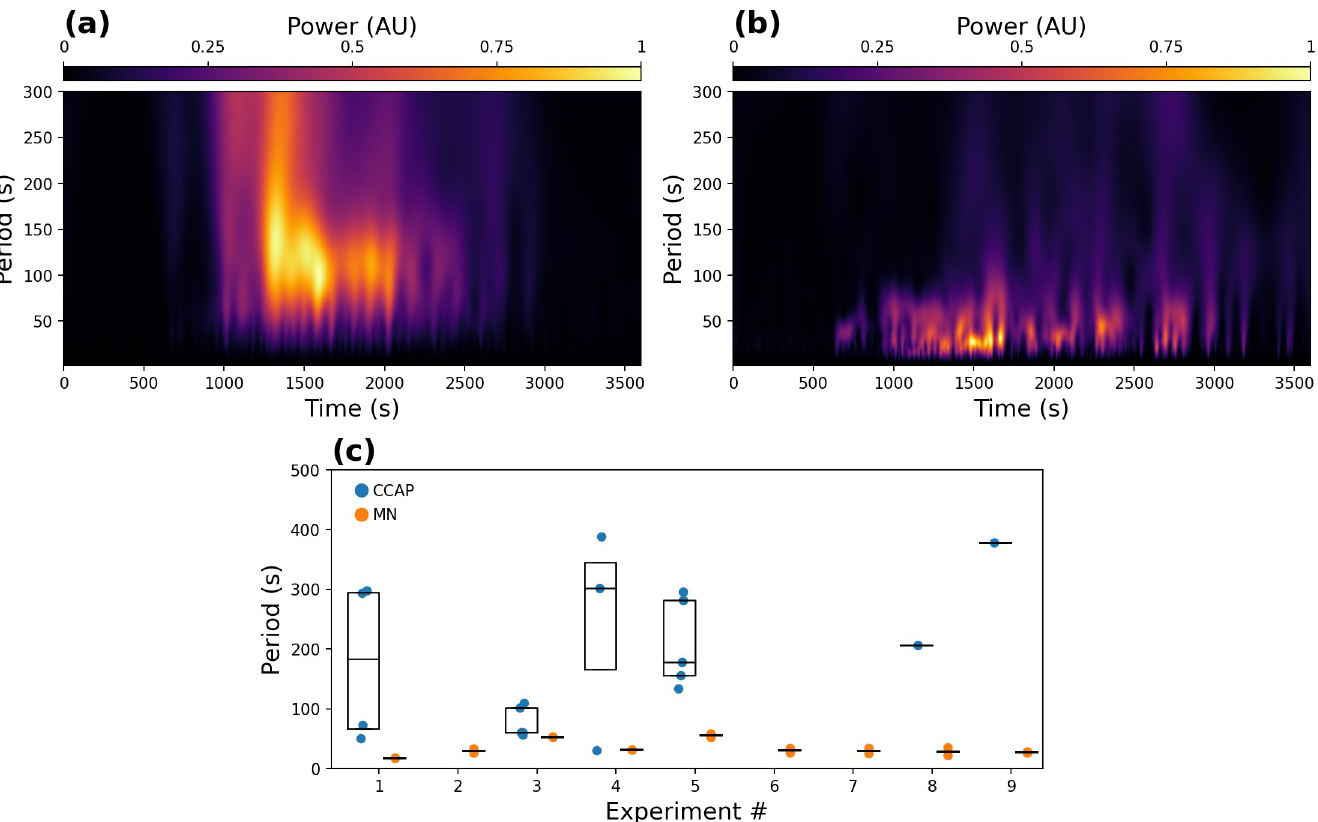
Fig 2. Oscillation period of CCAP neurons and motoneurons. (a, b) Average scaleogram for all α CCAP neuron ( a ) and motoneuron time series ( b ). (c) Mean oscillation periods of CCAP neurons and motoneurons for all 9 experiments. For CCAP neurons, only the data for neurons that passed the selection criteria are shown (see text). In some experiments none were accepted, and the data are missing. By contrast, in all experiments motoneurons of the left and right regions showed a dominant oscillation period.